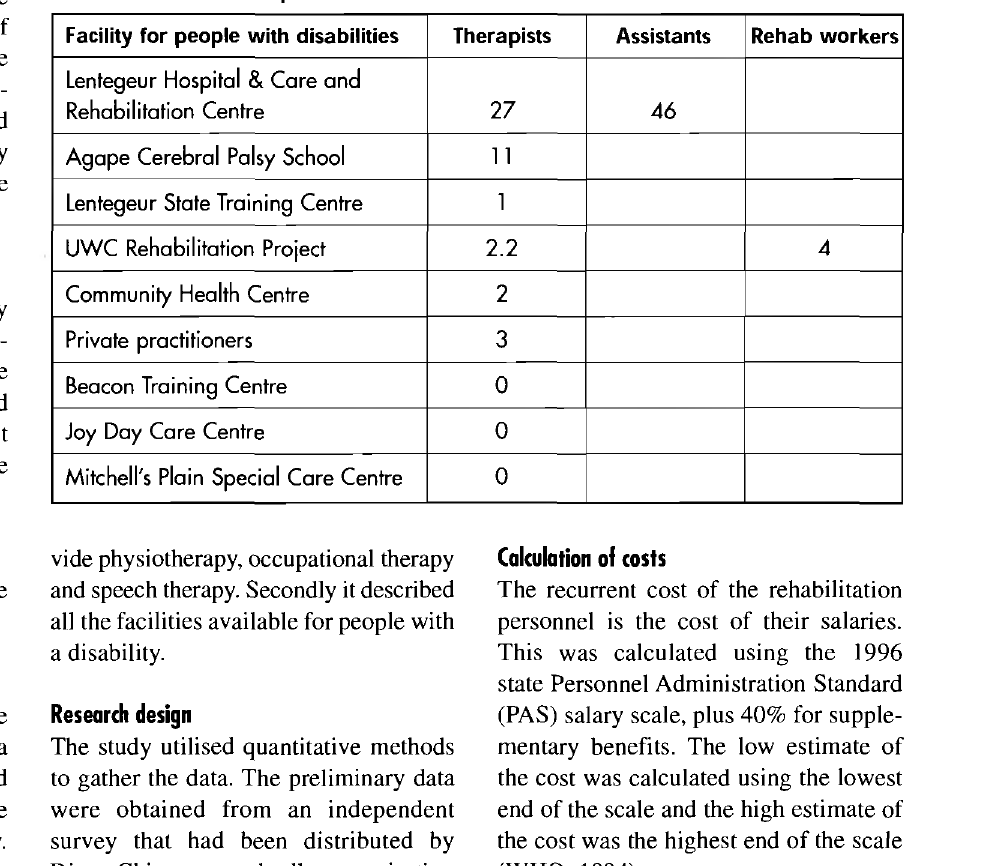
Table 1: Rehabilitation personnel in Mitchell's Plain